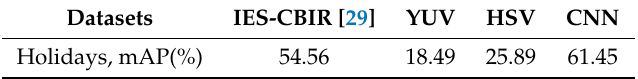
Table 1. Retrieval performance of individual